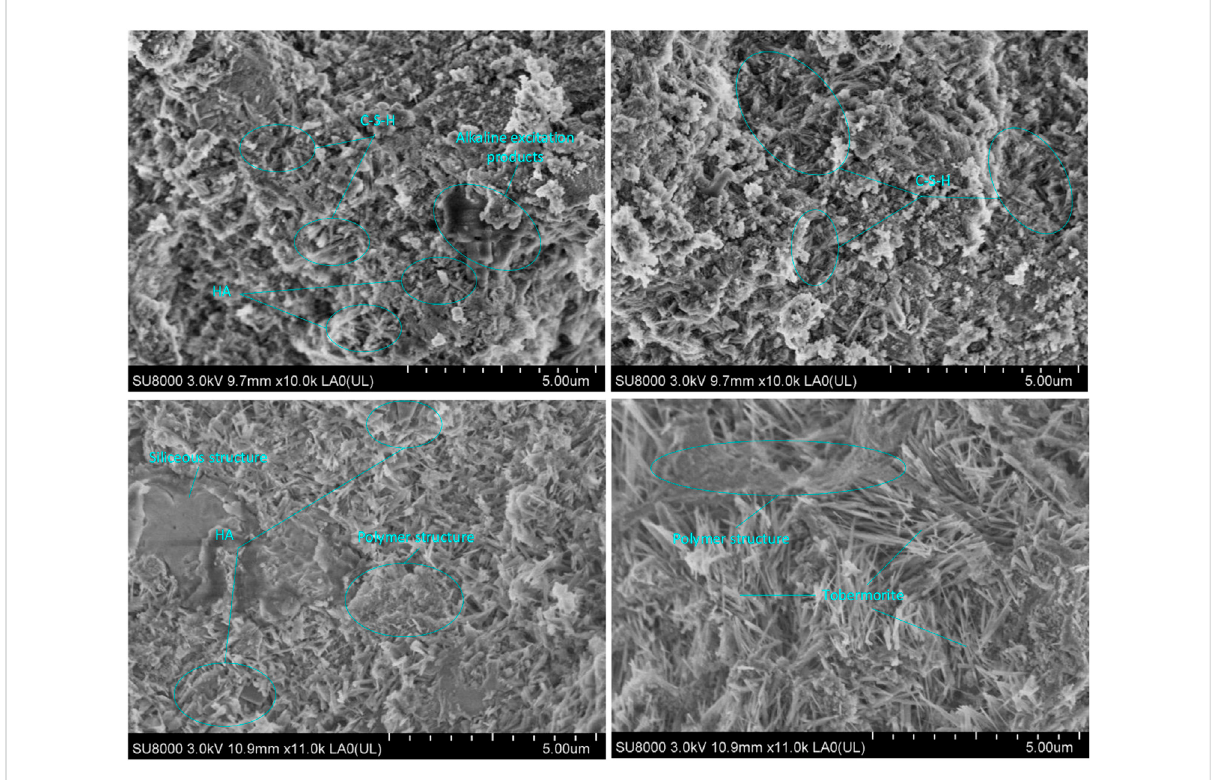
FIGURE 16 Microstructure of non-corrosive zone of BFs-HA-composite emulsion base cement